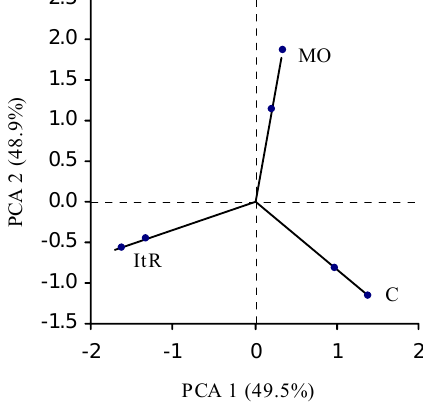
Figure 4. Principal component score plot (PC1 and PC2) of the studied white wines based on spectrophotometric data for the total